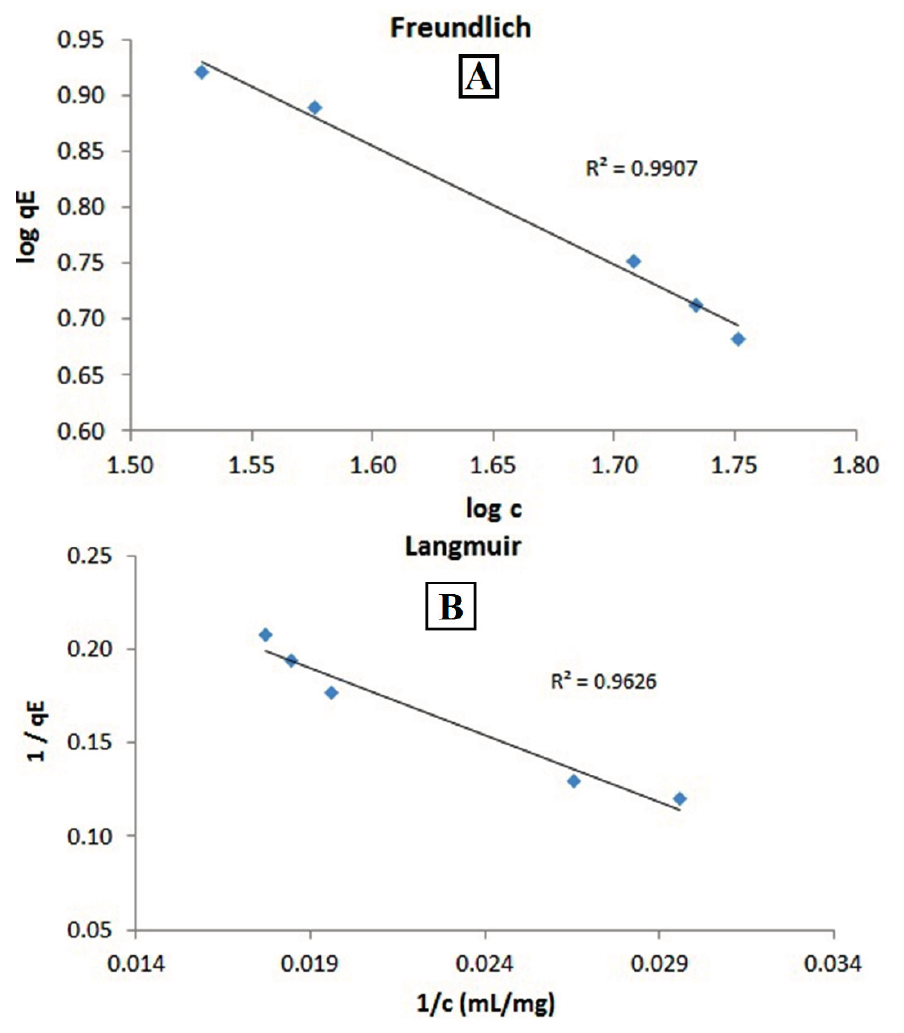
Figure 2. Linear plots of desorption isotherms of albumin from SEON LA-BSA . Freundlich ( A ) and Langmuir ( B ) isotherms showed a good determination coefficient R 2 .